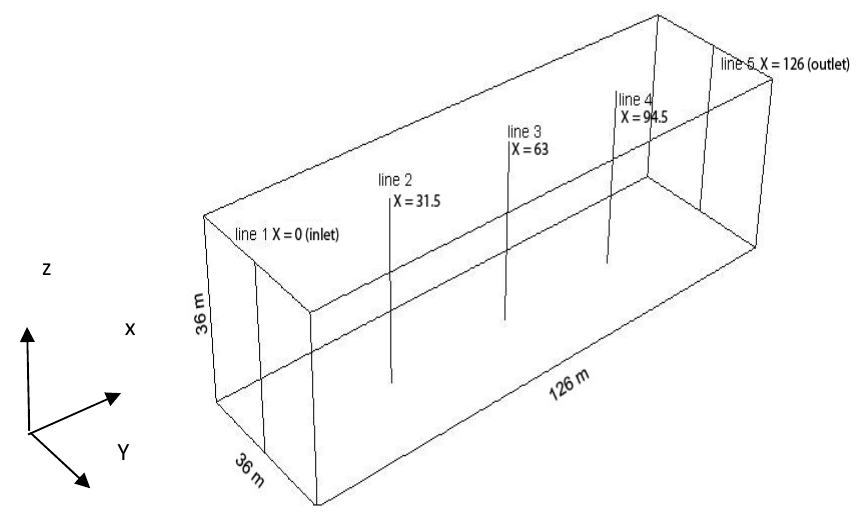
Figure 1. Computational domain dimensions and coordinates of locations L 1 (inlet), L 2 , L 3 , L 4 , and L 5 (outlet) where the vertical profiles of the streamwise velocity (u) profile and turbulent kinetic energy (TKE) ( k ) and turbulent dissipation rate (TDR) ( ε ) profiles were observed. The y-coordinate of all profiles is y = 18 m.